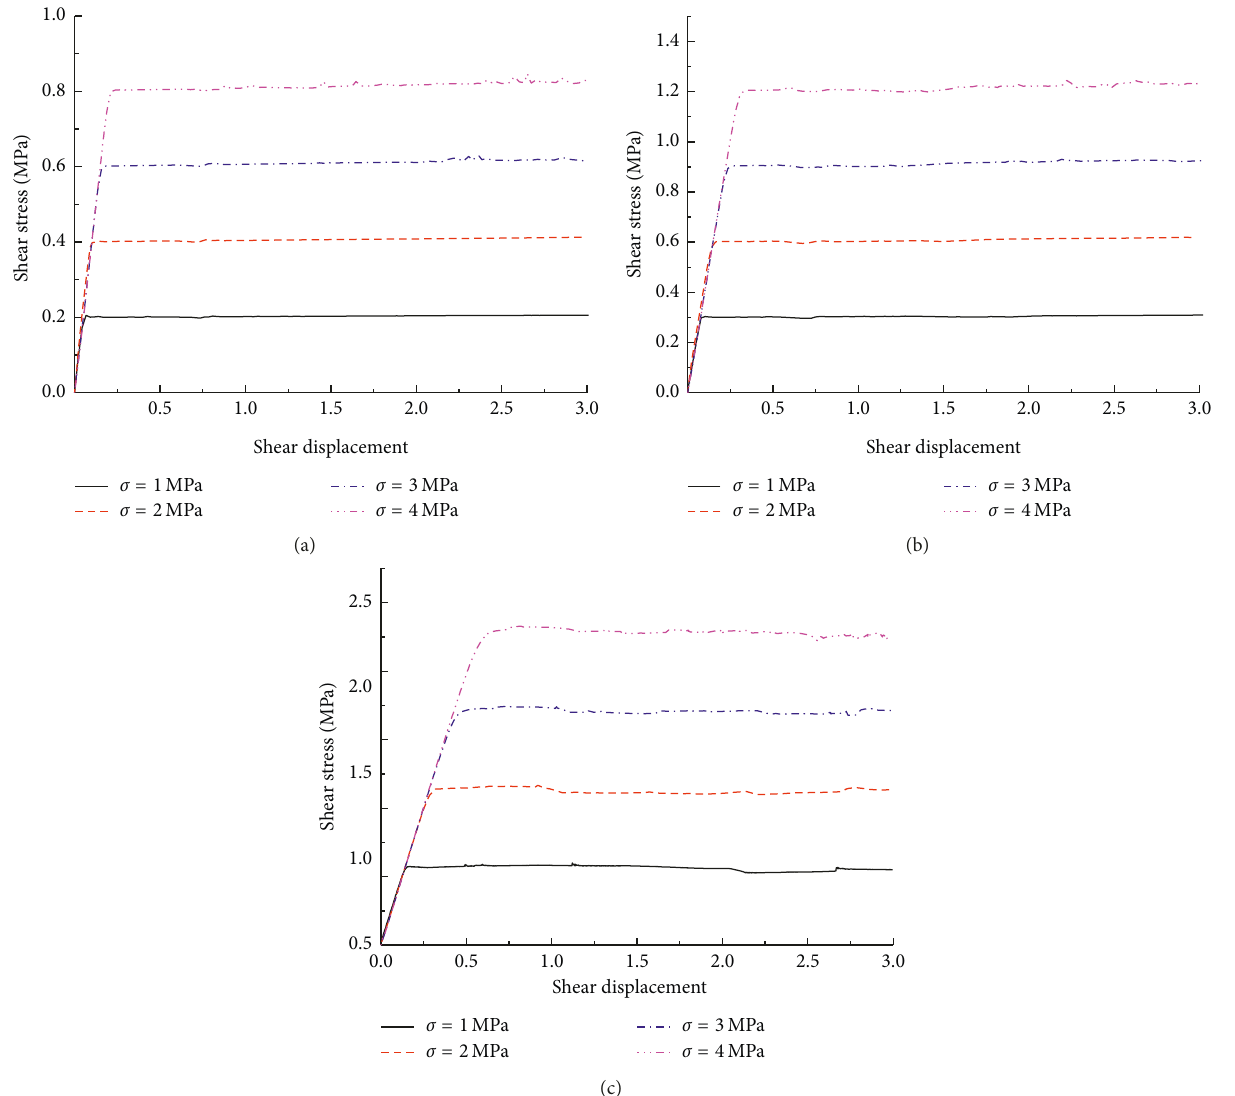
Figure 12: Relationship between the shear stress and displacement. (a) μ � 0.2; (b) μ � 0.3; (c) μ �